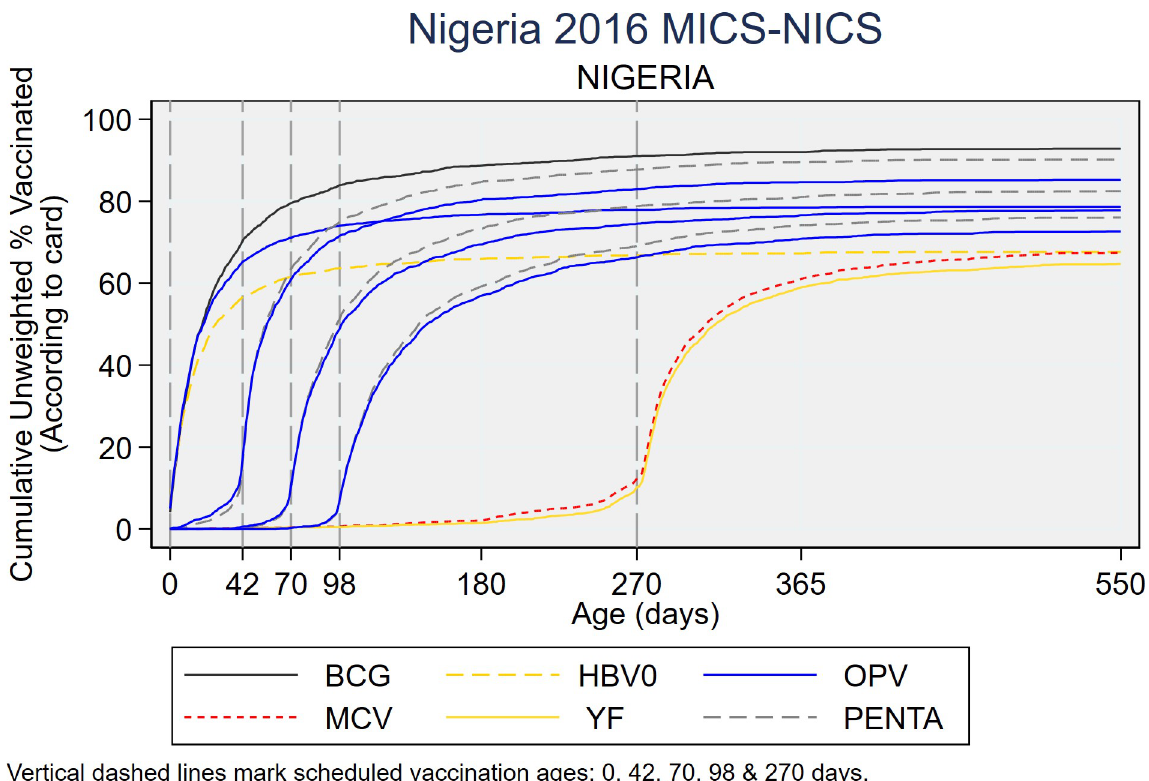
Fig 5. Cumulative coverage percentages for selected doses, by age of child, among children who showed a HBR to the interviewer, Nigeria MICS/NICS 2016–17.